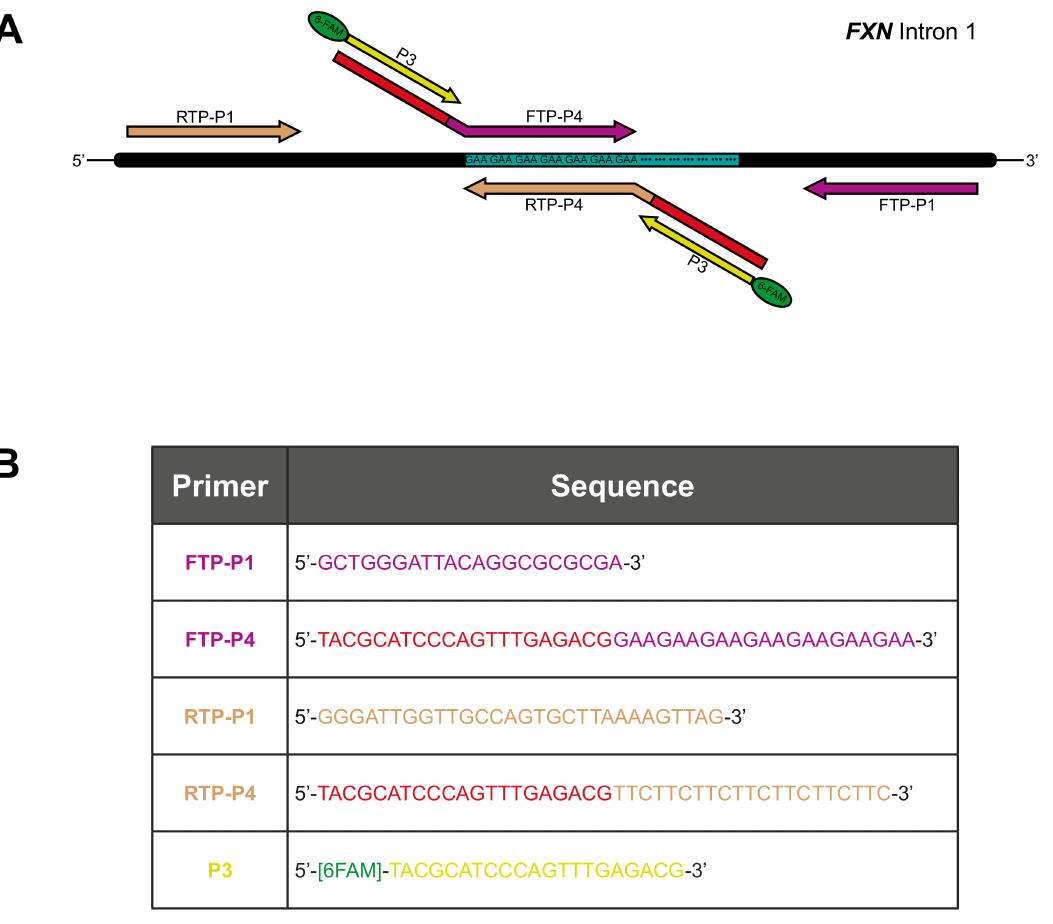
Figure 6. Triplet repeat primed PCR (TP PCR) strategy. ( A ) Schematic of the primer combinations used for Forward (FTP) and Reverse (RTP) TP PCRs with the FTP primers shown in magenta and RTP shown in taupe. The P4 primer tails are shown in red with the 6-FAM-labelled tail-specific primer P3 shown in yellow. ( B ) Table of primer